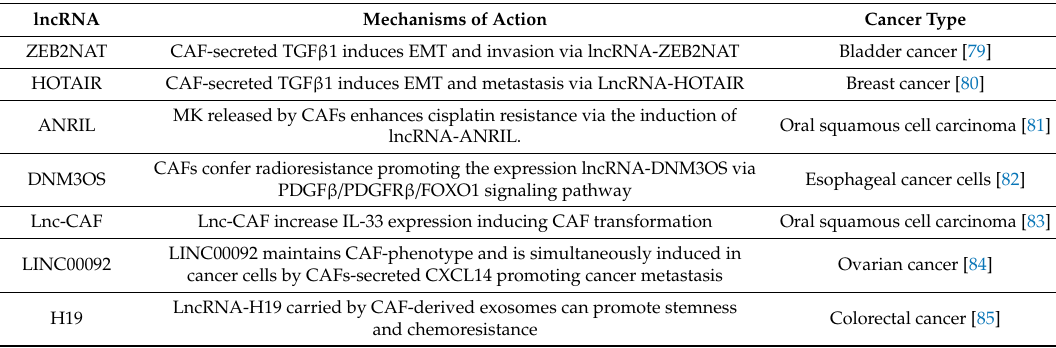
Table 2. Examples of lncRNAs involved in the crosstalk between CAFs and tumor